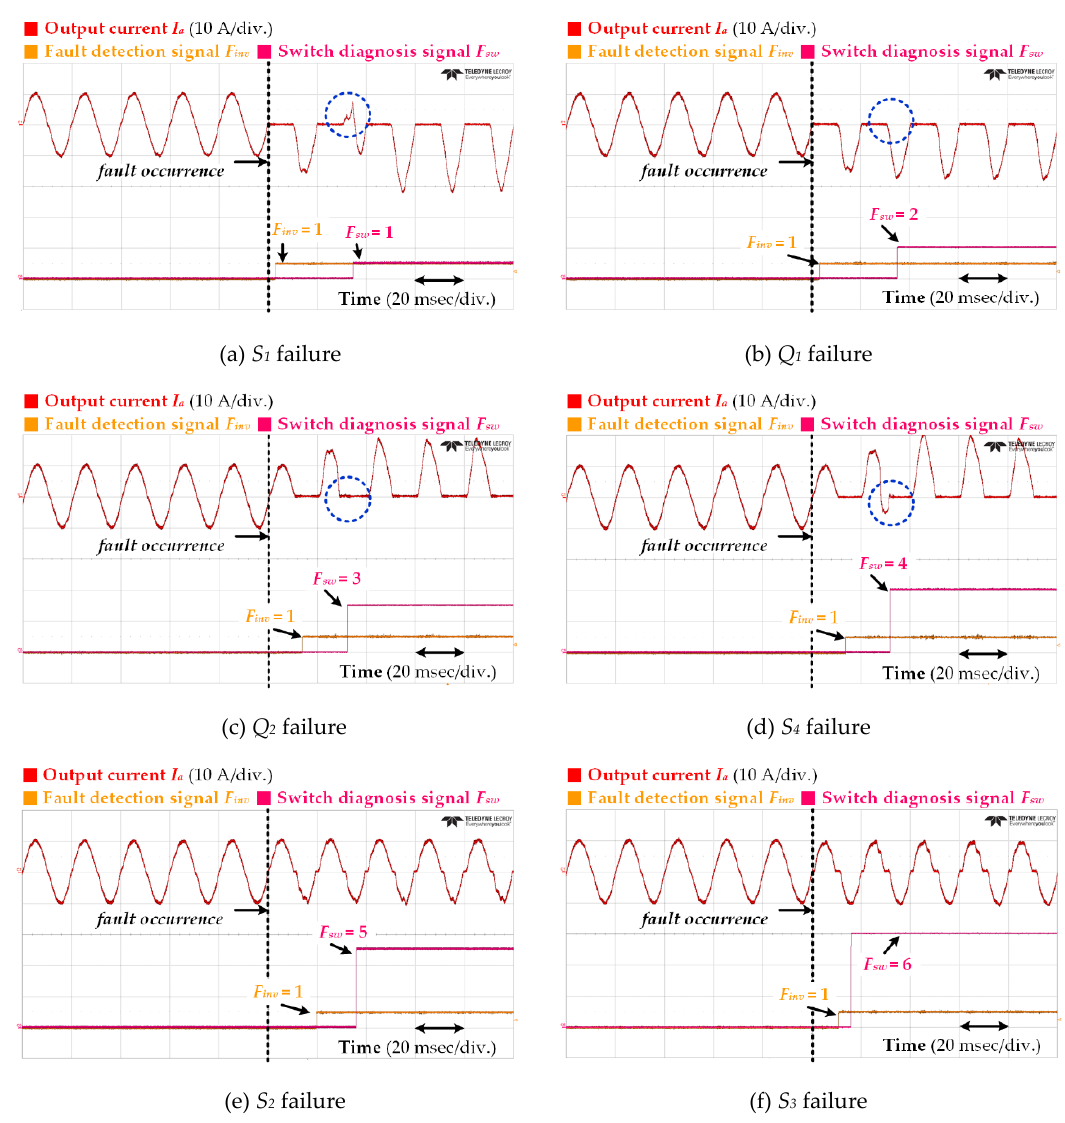
Figure 14. Measured current waveforms and fault detection signals.